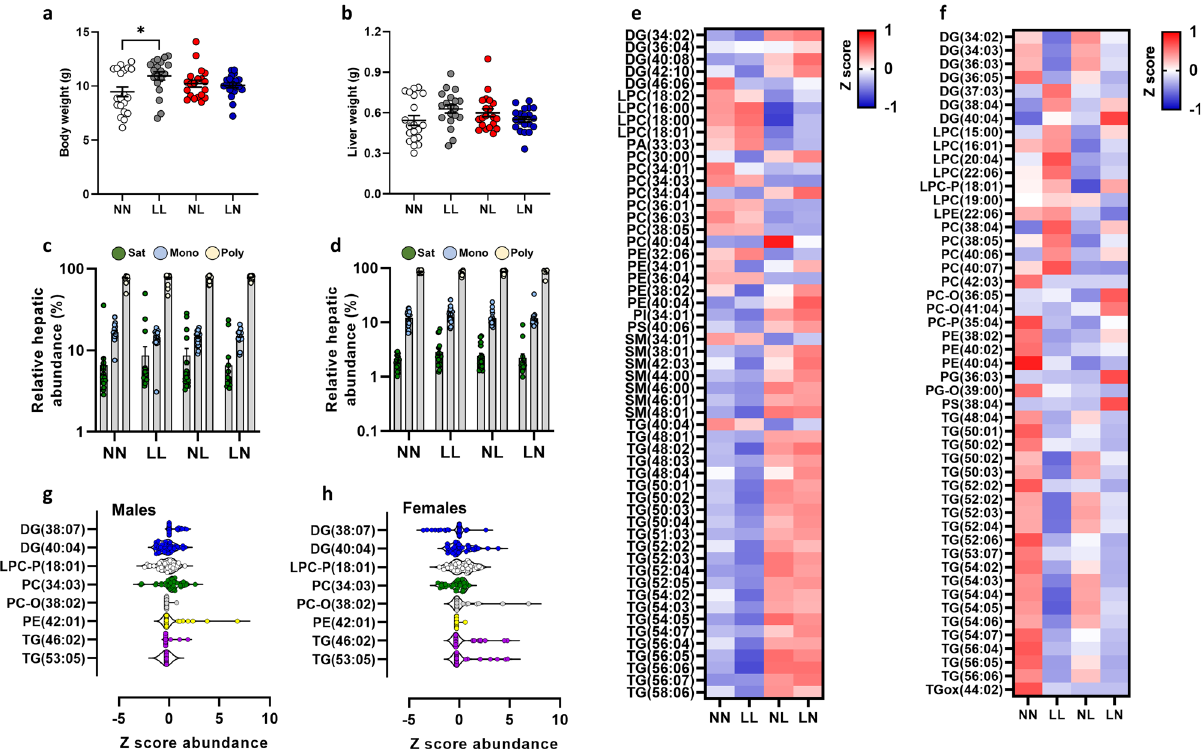
Fig. 5 Assessment of second-generation (F2) offspring lipid pro fi les. a Body weight and b liver weight of NN (NPD sperm and NPD seminal plasma), LL (LPD sperm and LPD seminal plasma), NL (NPD sperm and LPD seminal plasma) and LN (LPD sperm and NPD seminal plasma) F2 offspring at 3 weeks of age. Relative c hepatic and d serum abundance of saturated (Sat) mono-unsaturated (Mono) and poly-unsaturated (Poly) lipids. e Z scores of differential lipids between NN, LL, NL and LN offspring in e liver tissue and f serum. Cer ceramide, DG diglyceride (water-loss product from fragmentation in source), LPC lyso -phosphatidylcholine, LPE lyso-phosphatidylethanolamine, LPG lyso-phosphatidylglycerol, PA phosphatidic acid, PC phosphatidylcholine, PC-P phosphatidylcholine plasminogen, PC-O phosphatidylcholine plasmalogen, PE phosphatidylethanolamine, PI phosphatidylinositol, SM sphingomyelin, TG triglyceride, TGox oxidised triglyceride. Differential serum lipids in g male and h female offspring. N = 5 – 10 males and females per treatment group, selected from all litters generated. ∗ p < 0.05. Statistical differences were determined using one-way ANOVA with Bonferoni post hoc